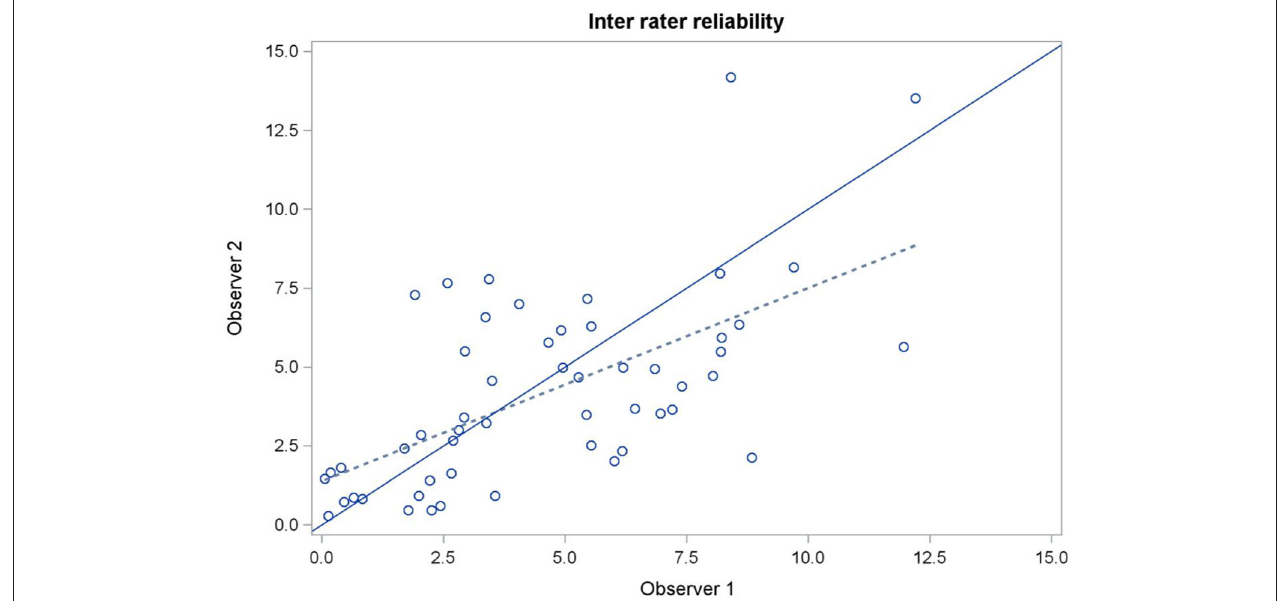
FIGURE 4 | Concordance correlation plot comparing inter-rater reliability for mechanical nociceptive threshold quantified using a handheld pressure algometer. Data obtained using one measure per day for five consecutive days on 36 milking cows. The full line represents the line of perfect concordance and dashed line represents reduced major axis.